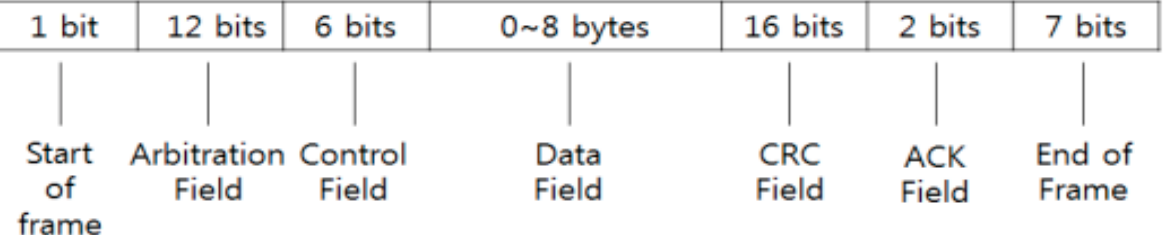
Figure 2. CAN bus data Frame.